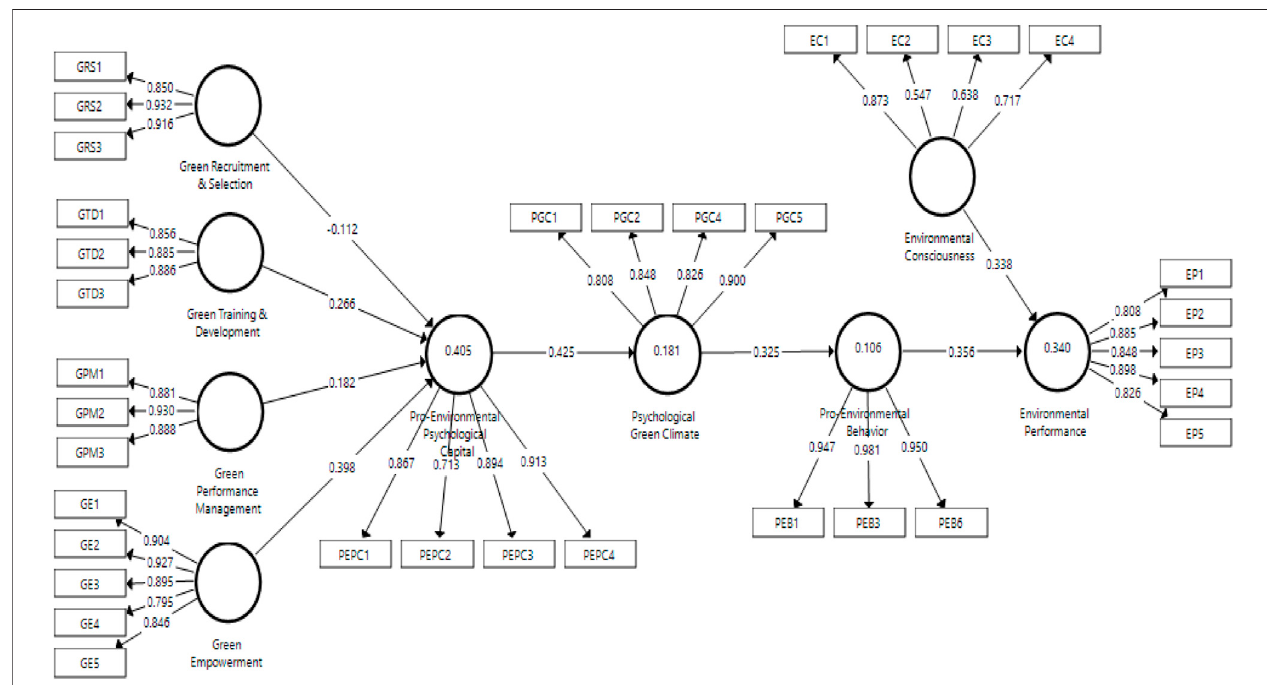
FIGURE 2 | Measurement model assessment.